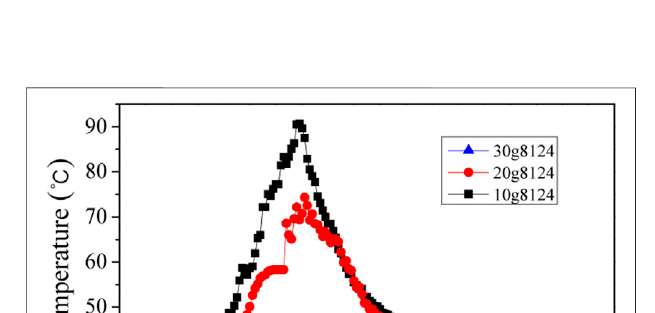
FIGURE 6 | The result of fl ue gas temperature by using foam with Mg(OH)